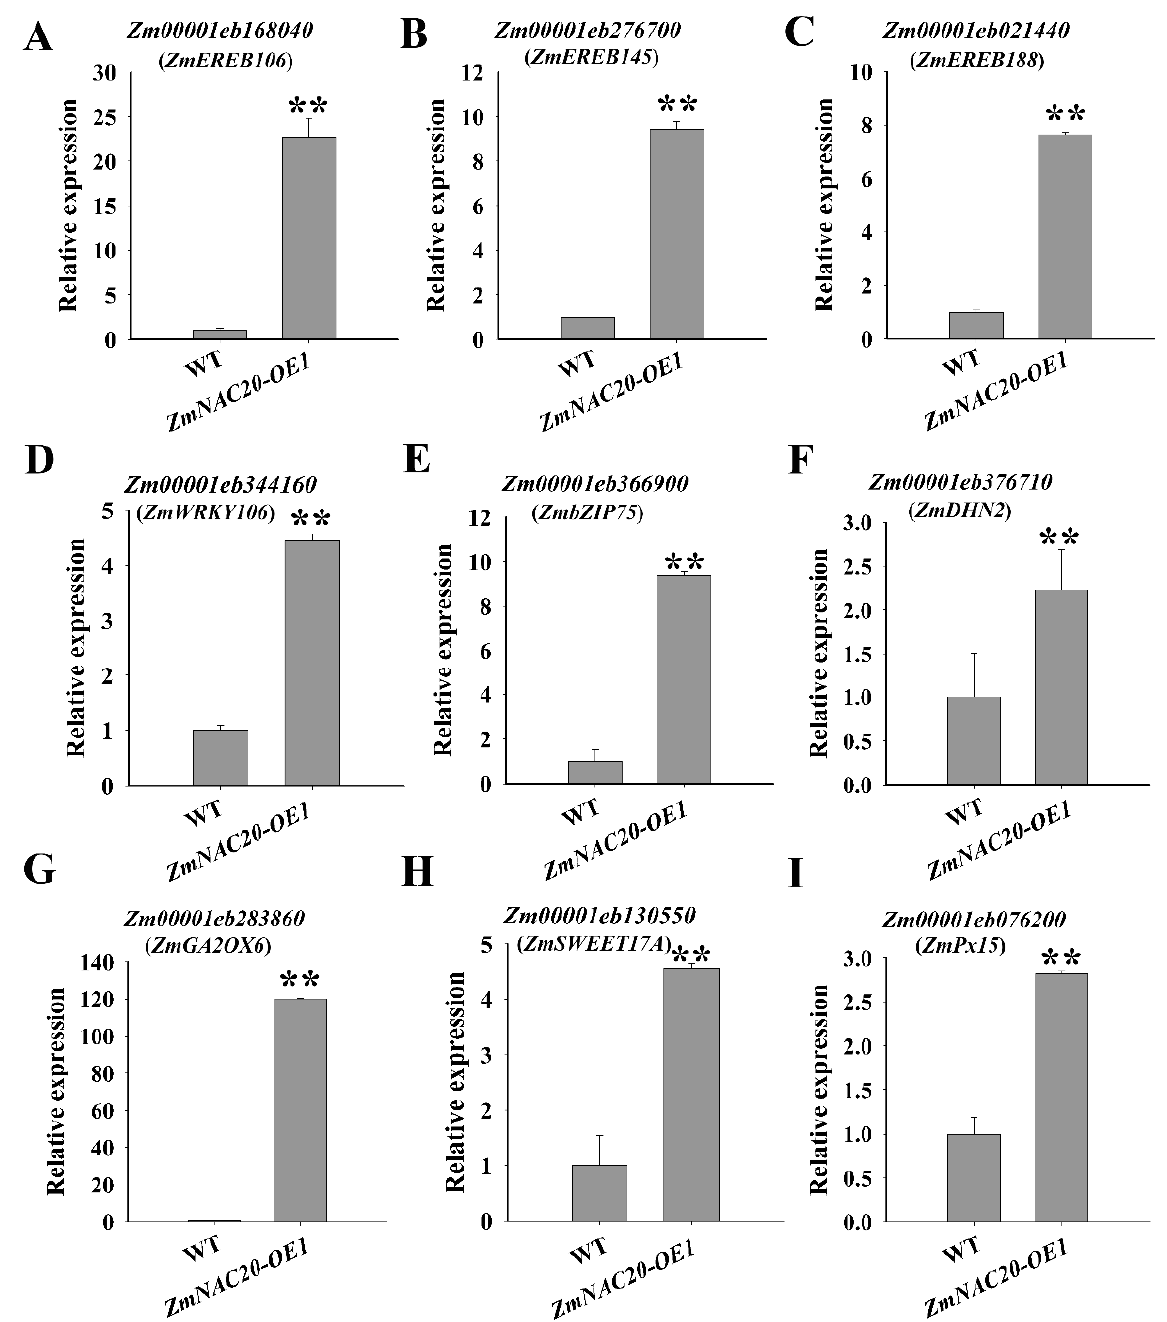
Figure 6. ( A – I ) Expression of genes involved in drought stress response in ZmNAC20-overexpressing seedlings under drought stress. The seedlings were treated by dehydration for 3 h. SD values were calculated from three biological replicates Asterisks indicate significant differences: ** p < 0.01 (Student’s t -test), ns indicates no significance.